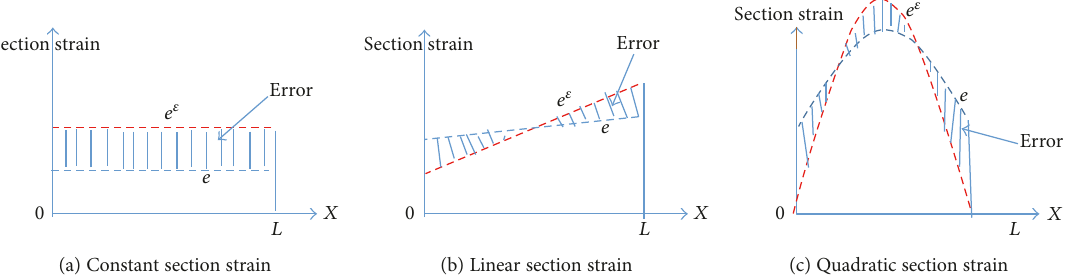
Figure 4: Distribution and error of section strains in di ff erent orders. e ε is a section strain in e ε computed from surface strain measurements by (8). e is a section strain in e u deduced by